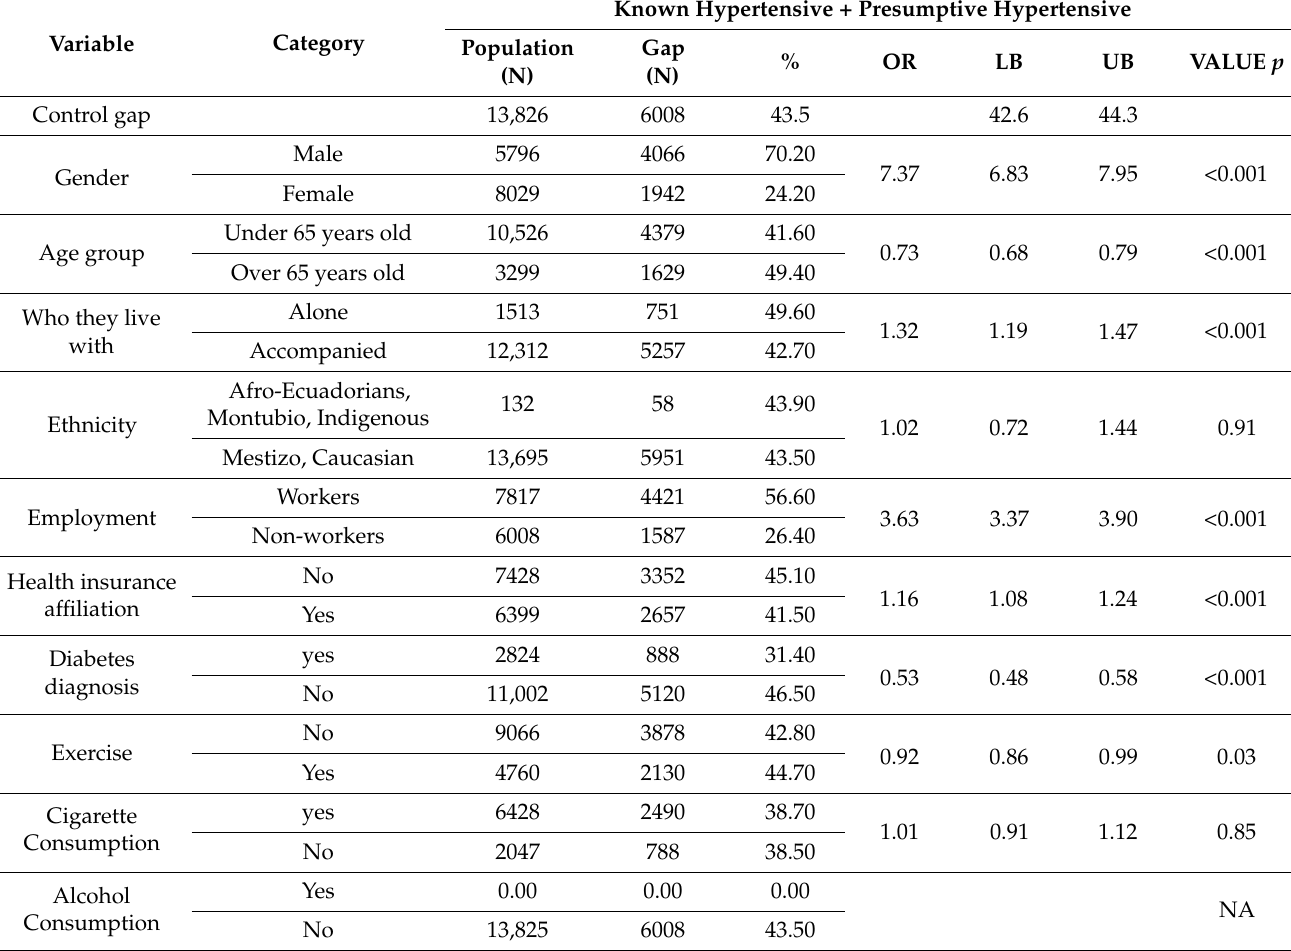
Table 4. Associated factors to the Control Gap at the population level.